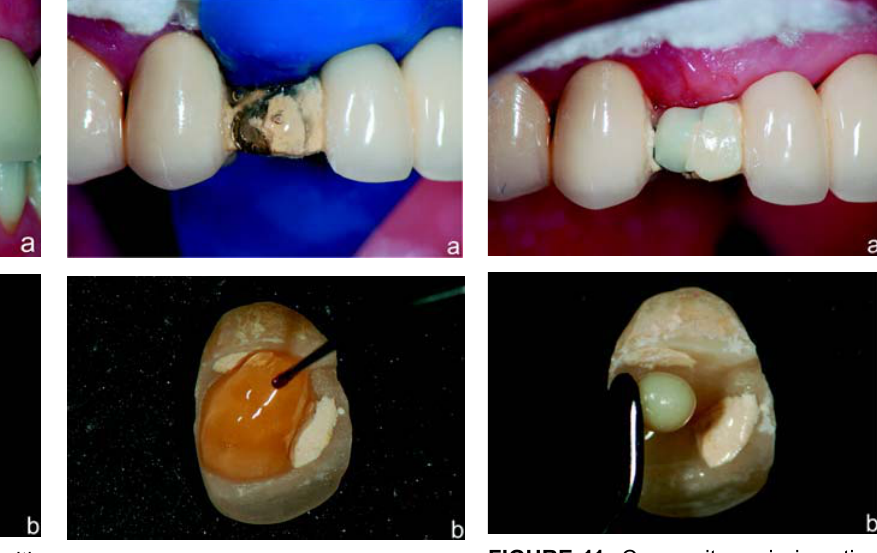
FIGURE 10- Etching of the prosthesis (a) and ceramic fragment (b) with 10% hydrofluoric acid